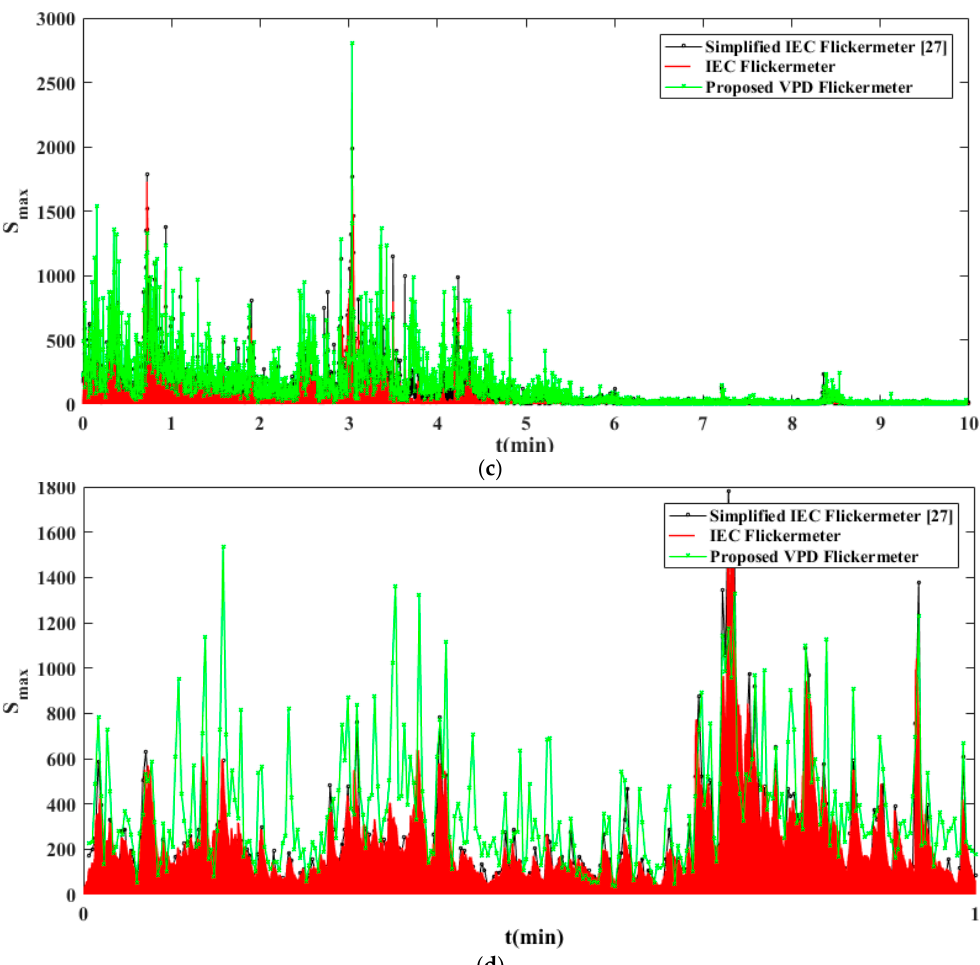
Figure 3. Evaluations for phase 1 ( a ) RMS variation; ( b ) fundamental frequency variation; ( c ) comparison of 10 min S max for different methods; ( d ) comparison of 1 min zoomed version of S max for different methods.